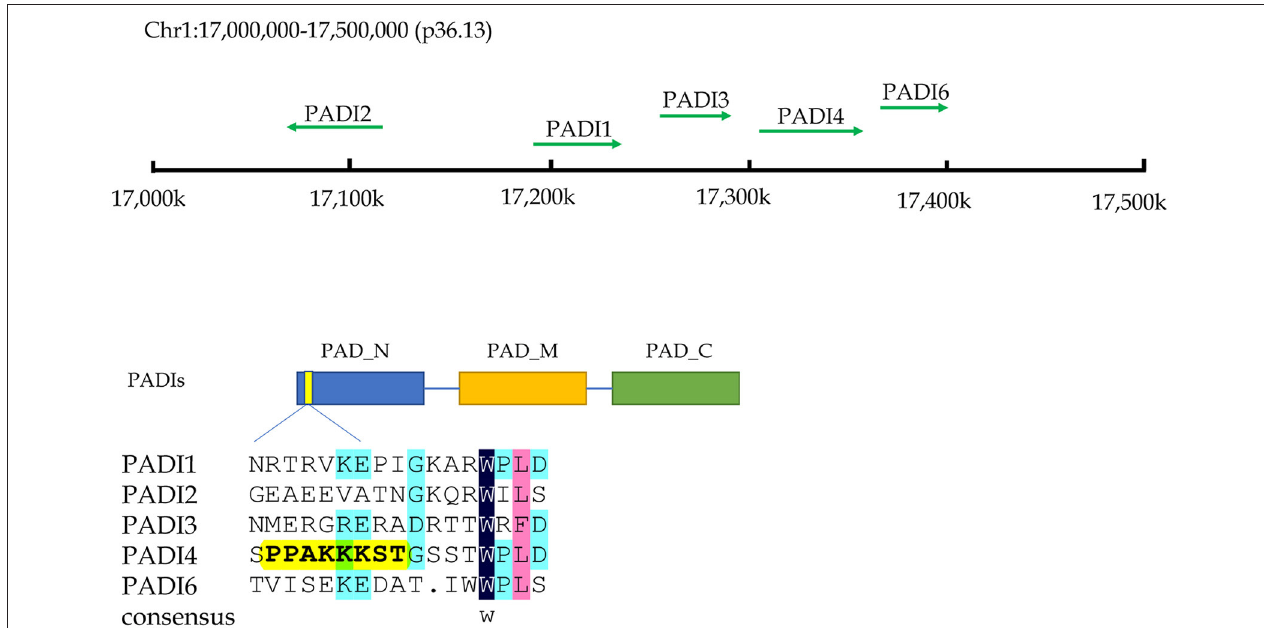
FIGURE 2 | The chromosome location and structural characteristics of PADIs family. Five PADIs genes (PADI 1, 2, 3, 4, and 6) are located in the p36.13 of chromosome 1 across a region of approximately 500k bases. PADIs members have similar structural regions, which can be divided into three sections: nitrogen zone, middle zone, and carbon end catalytic zone. Only PADI4 contains a nuclear localization signal at the nitrogen end of sequence, implying that PADI4 may play a role in the cell